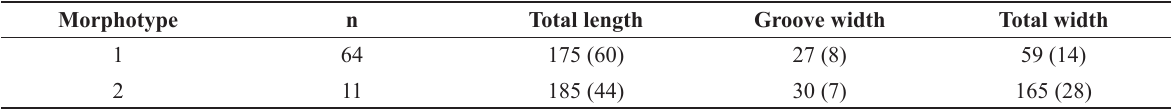
Measurements (in mm) of tooth marks (morphotypes I and II). n = number of measured traces. Average deviation in